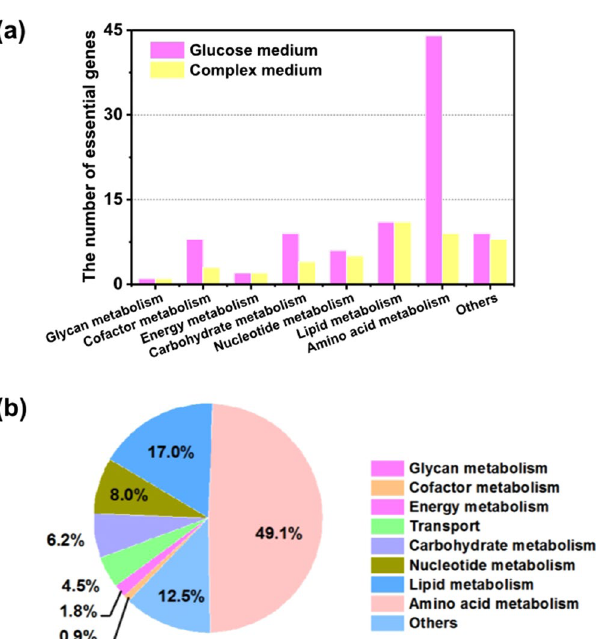
Figure 3. Distribution of essential genes and reactions in each subsystem. ( a) The distribution of essential genes in a glucose-containing medium and a complex medium. (b) The percentage of essential reactions in each subsystem in a glucose-containing